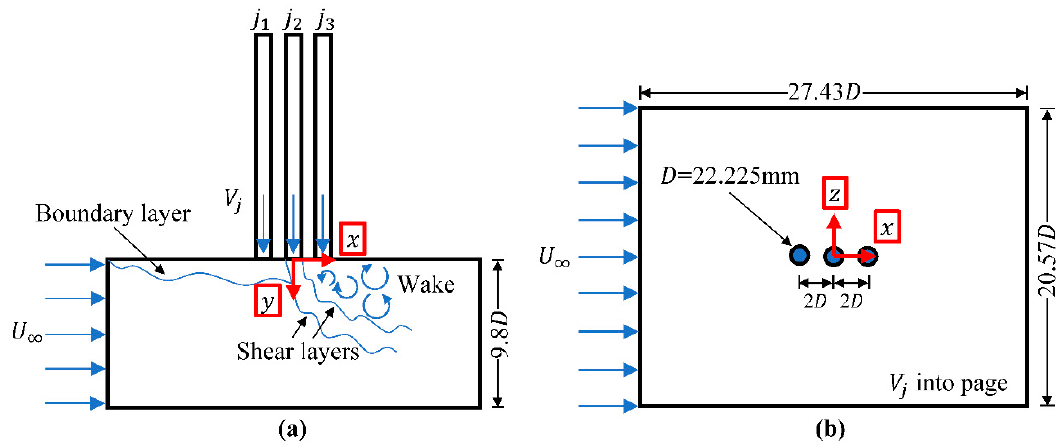
Figure 2. Test section including ( a ) side view depicting xy plane and ( b ) top view depicting xz plane. Reproduced with permission from Kristo and Kimber, Time-resolved particle image velocimetry measurements of a tandem jet array in a crossflow at low velocity ratios [15]; published by Springer Nature, 2021.